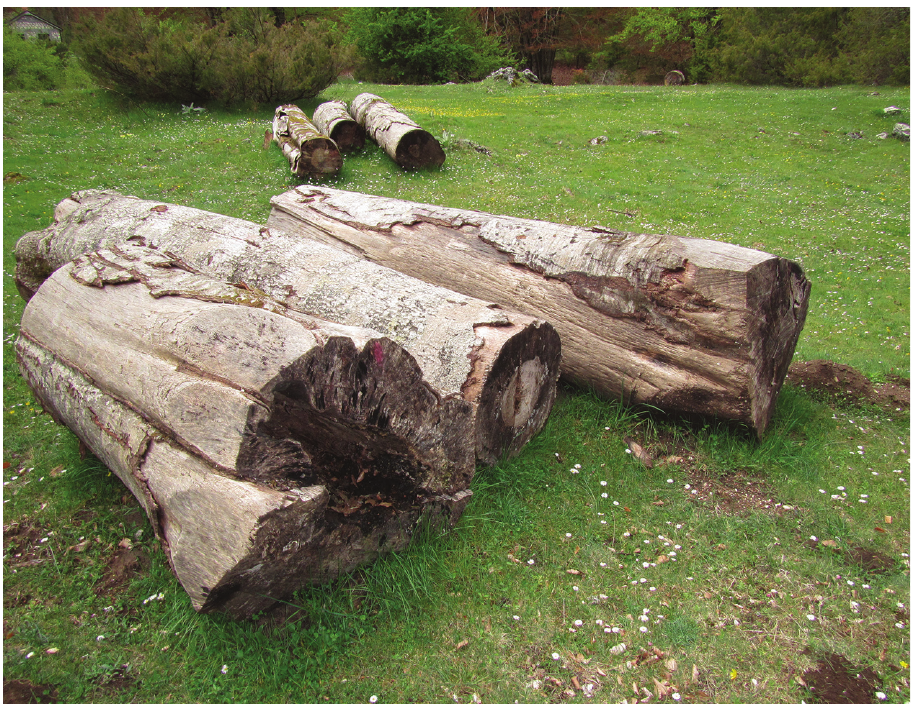
Figure 5. A group of logs used as sampling unit for monitoring the presence of R. alpina in the Abruzzo, Lazio and Molise National Park in 2016.